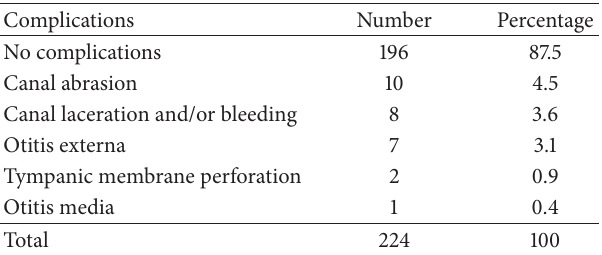
Table 3: Complications of aural foreign body extraction from 224